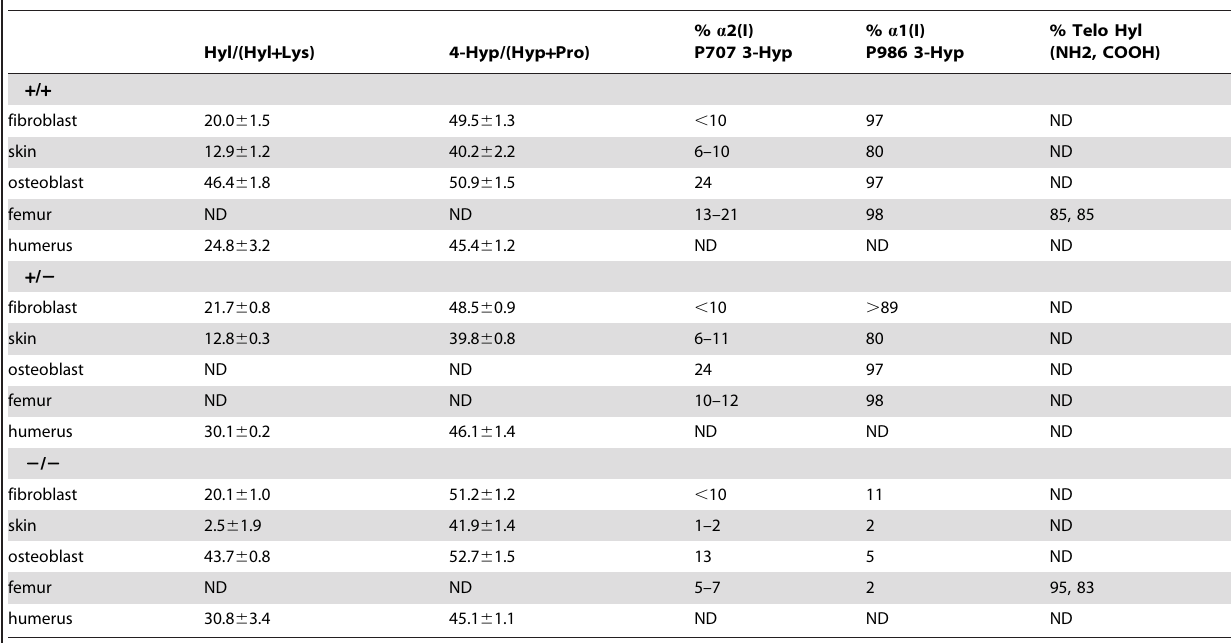
ND, Not determined.